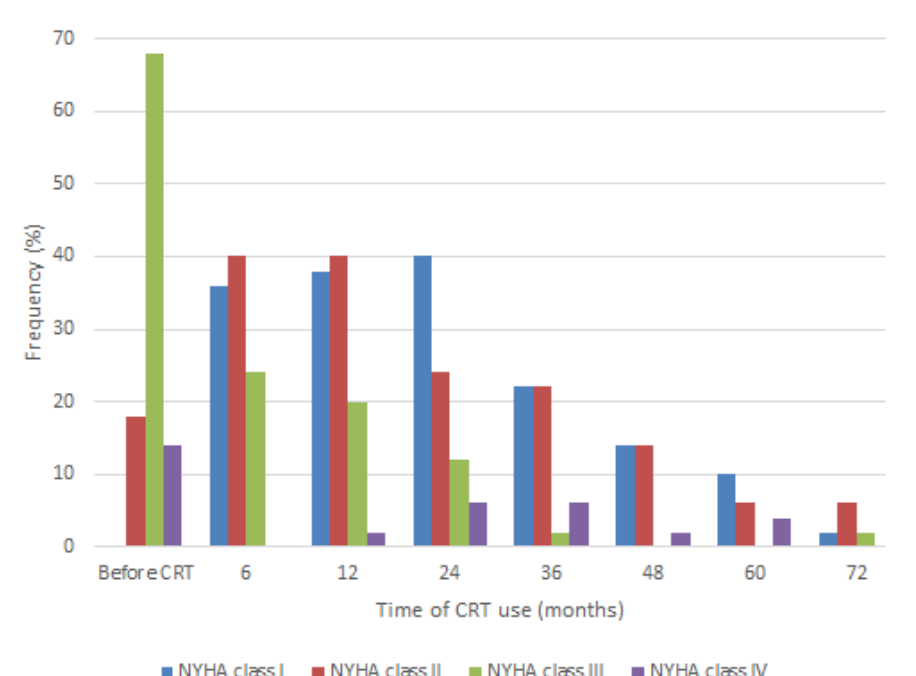
Fig. 2 – Variation of New York Heart Association (NYHA) functional class presented by the patients over the cardiac resynchronization therapy (CRT)